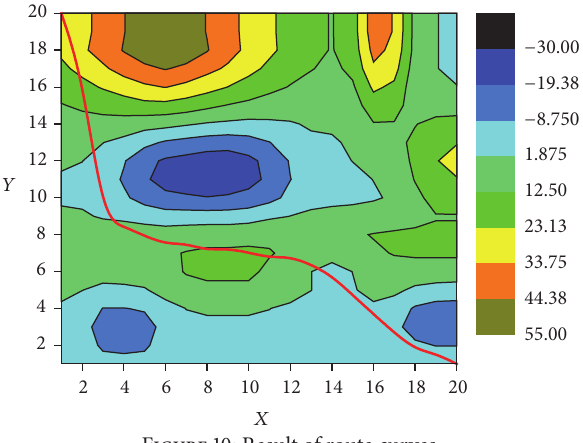
Figure 10: Result of route curves.